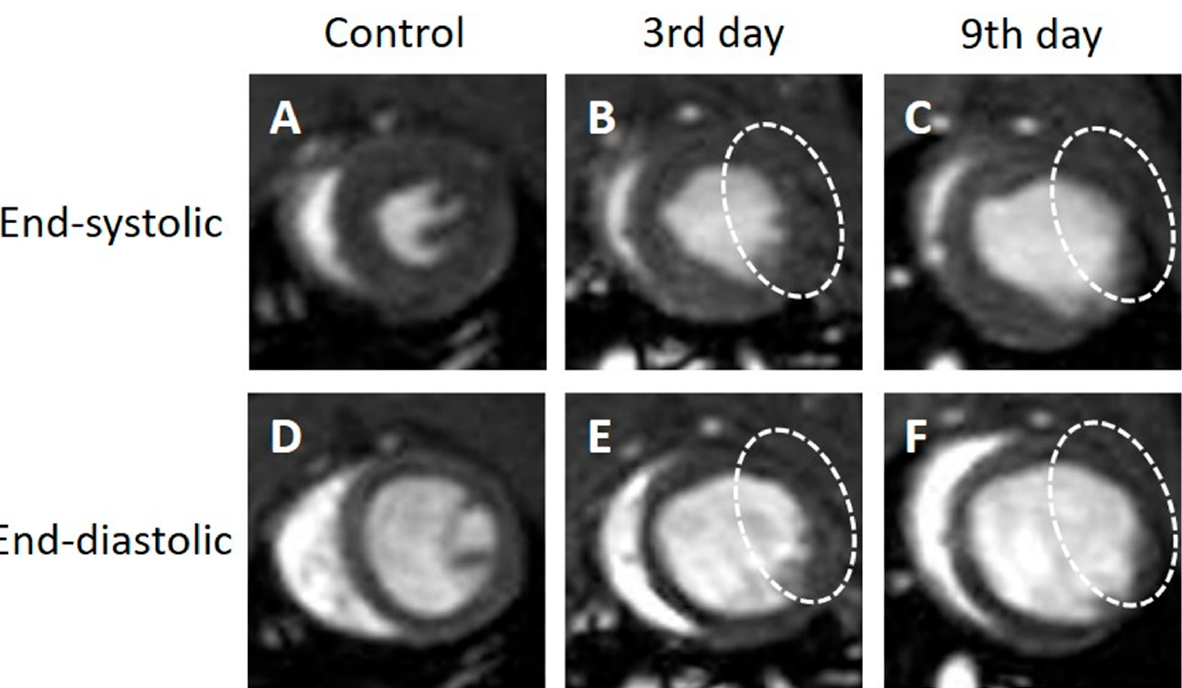
Figure 3. Representative short-axis view cine magnetic resonance images. Control ( A , D ), 3 days after the onset of myocardial infarction ( B , E ), 9 days after the onset of myocardial infarction ( C , F ). End-systolic phase of the rat heart ( A , B , C ), end-diastolic phase of the rat heart ( D , E , F ). White dotted circles: infarcted area.